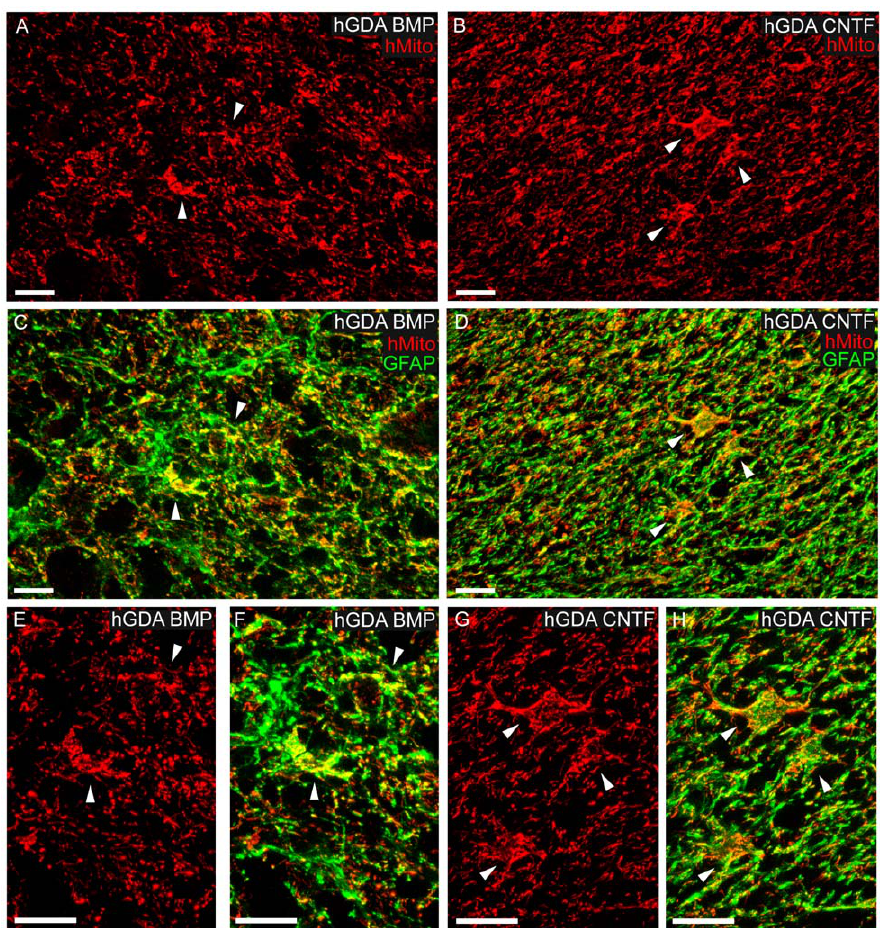
Figure 3. GFAP expression by transplanted hGDAs within DLF transection injuries. Images of hMito + (red) and GFAP (green) immuno- reactivity within hGDAs BMP (A, C, E, F) and hGDAs CNTF (B, D, G, H) transplants at the center of injury sites showing comparable densities of GFAP + intermediate filaments (green) within hMito immuno-positive cell bodies and process of both types of hGDAs. Arrowheads indicate some examples of GFAP + /hMito + hGDA cell bodies at low and high magnification. Images are maximum projections of apotome (Zeiss) optical sections captured through a depth of 3.5 m m of tissue. Survival=5 weeks post injury/transplantation. All scale bars=20 m m.